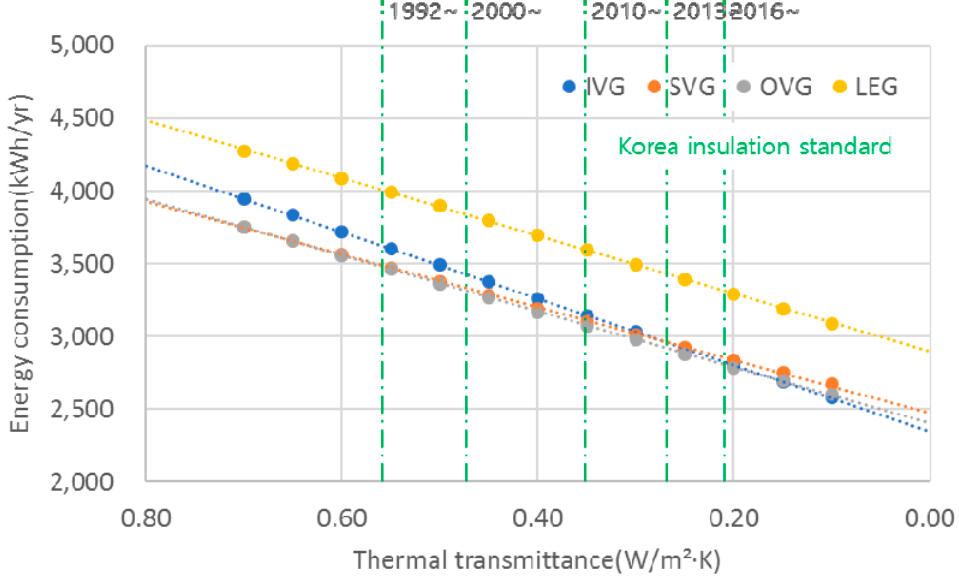
Figure 17. Changes in energy consumption due to insulation enhancement in residential buildings. Table 7. Cooling and heating energy due to insulation enhancement in residential buildings [kWh].